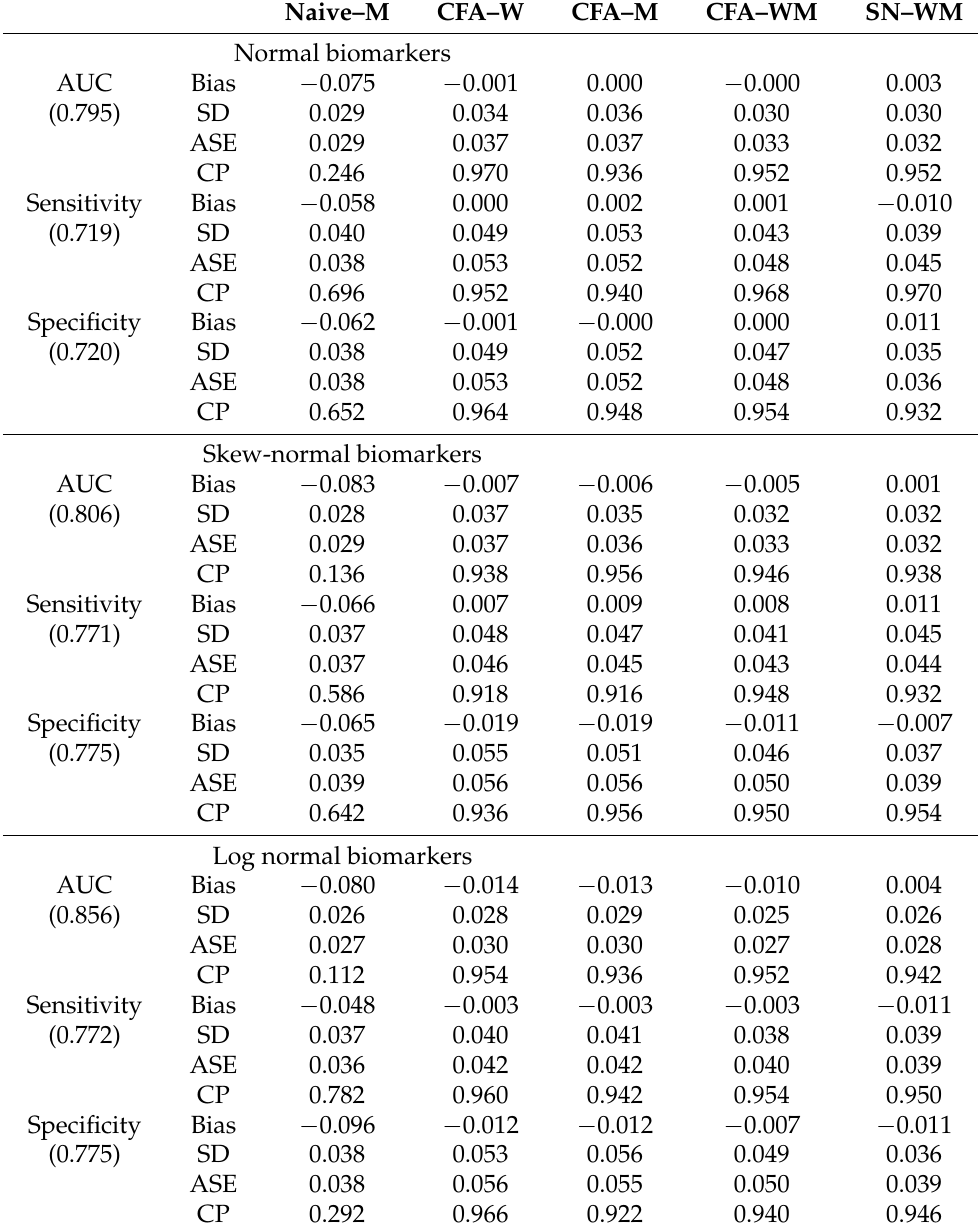
Table 1. Simulation study when σ u = σ v = 1 (replicates).